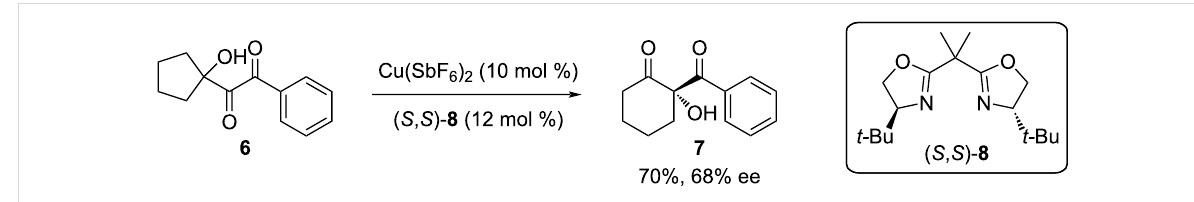
Figure 3: Enantioselective ring expansion of β -hydroxy- α -dicarbonyl 6 catalyzed by a chiral copper-bisoxazoline